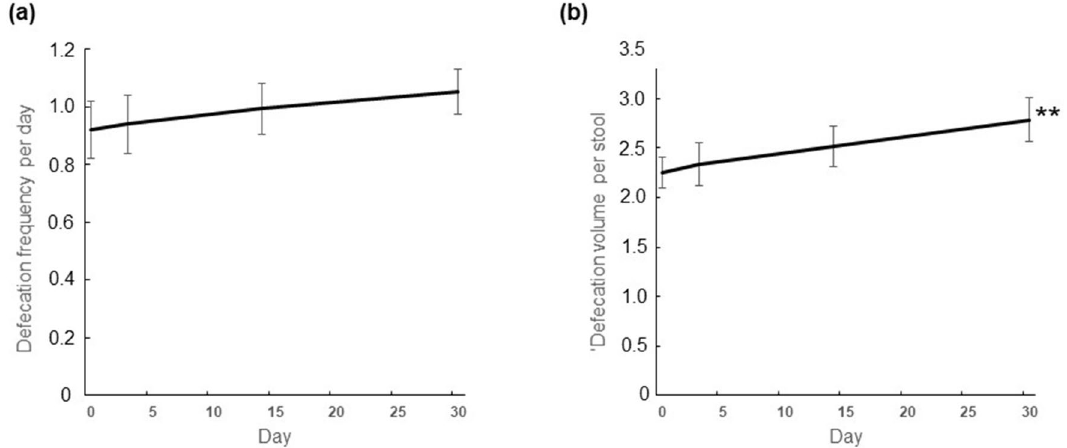
Figure 5. Euglena gracilis ingestion promotes defecation. ( a ) The frequency of defecation per day and ( b ) the volume of defecation per stool. One defecation volume is equivalent to one medium-sized chicken egg (about 60 g). Mean ± SEM, ** P < 0.01, n = 28, Wilcoxon signed rank